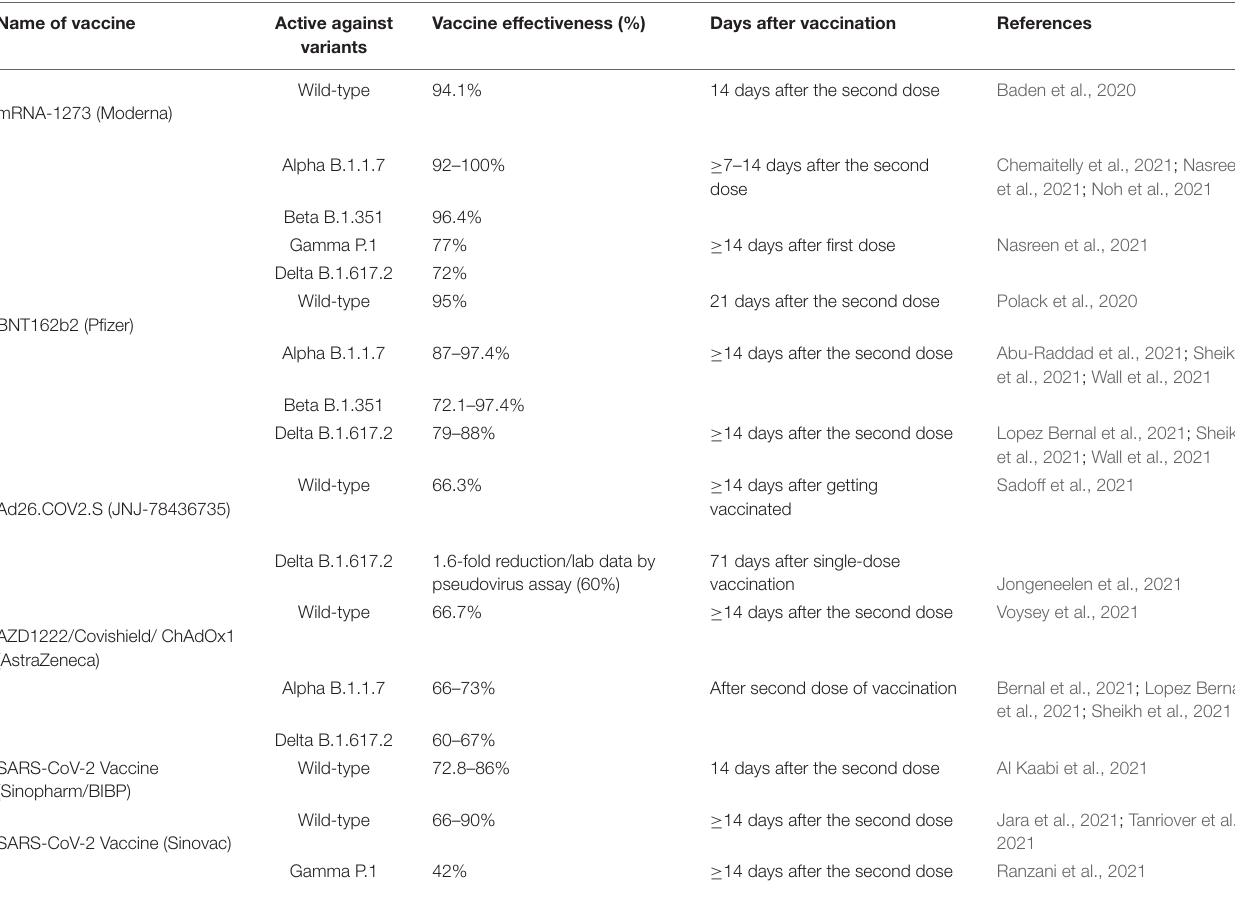
TABLE 4 | Effectiveness of approved vaccines against different SARS-CoV-2